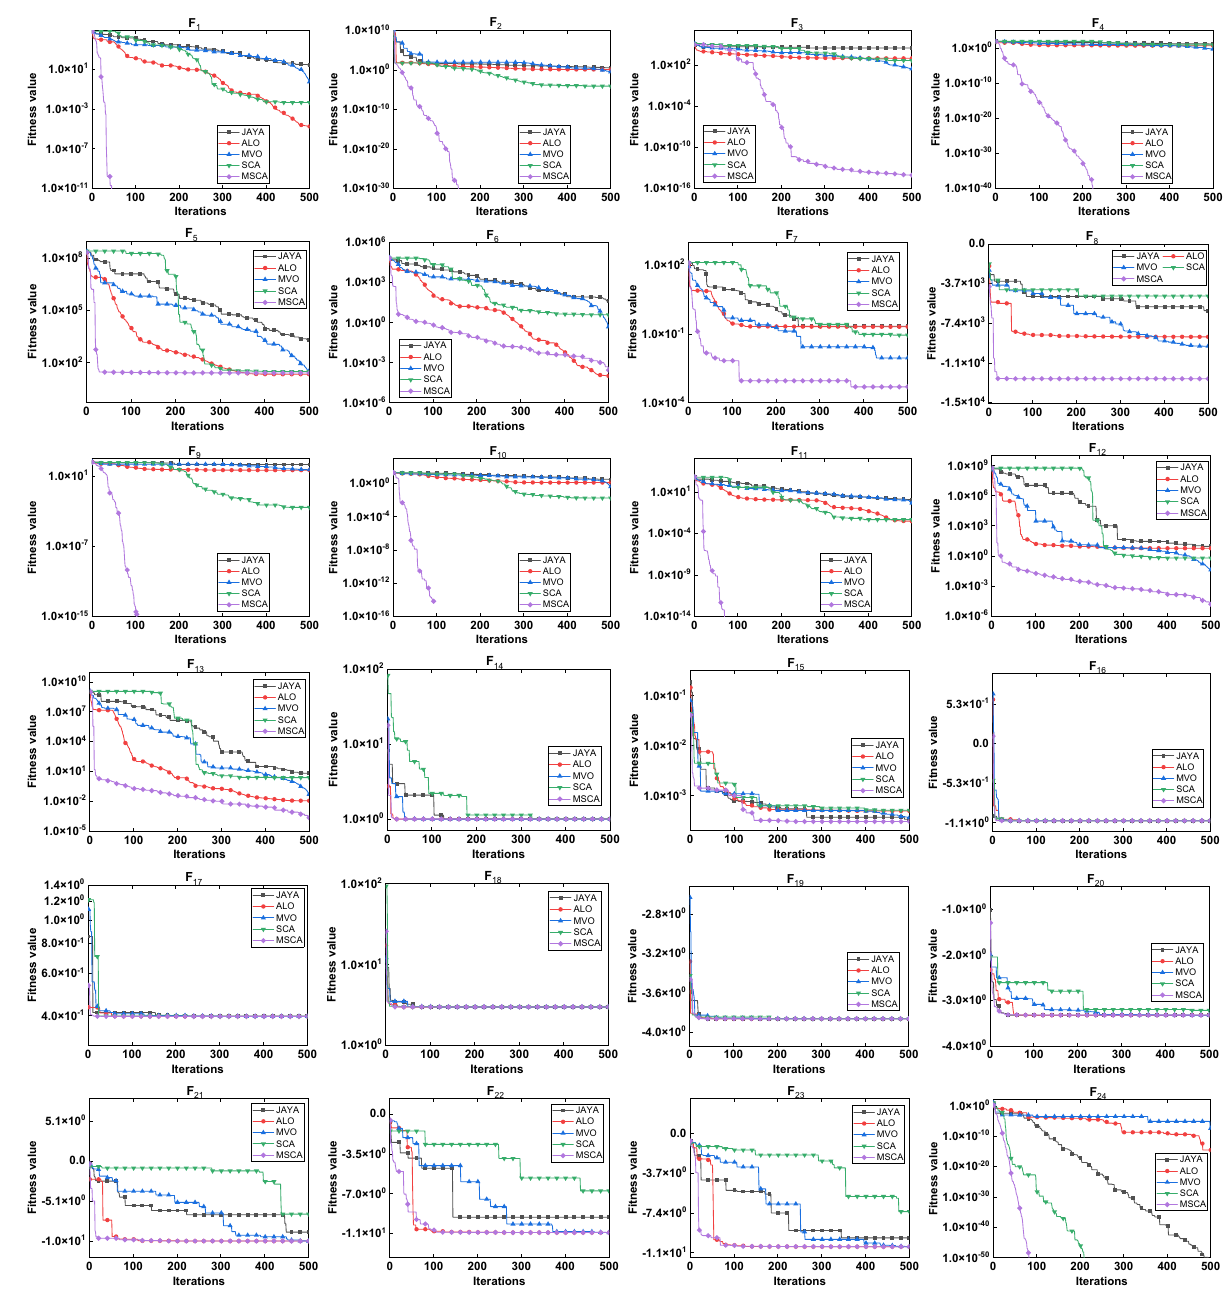
Figure 6. The convergence curve on classical benchmark